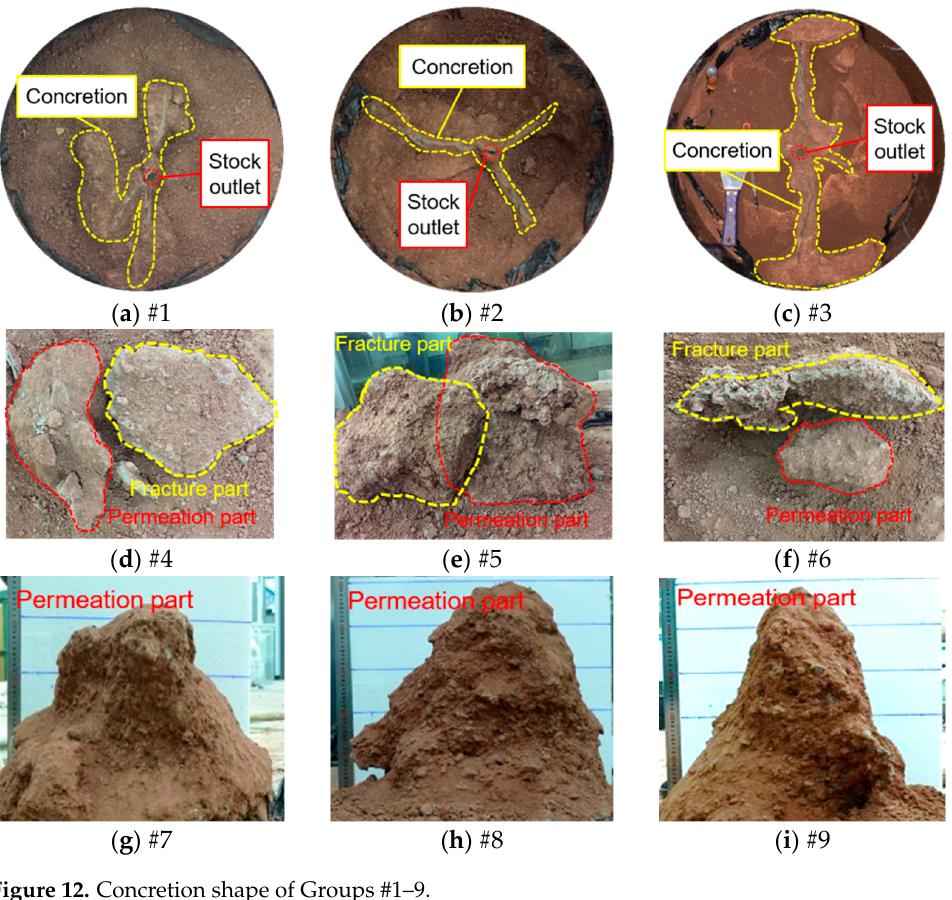
Figure 12. Concretion shape of Groups #1–9.